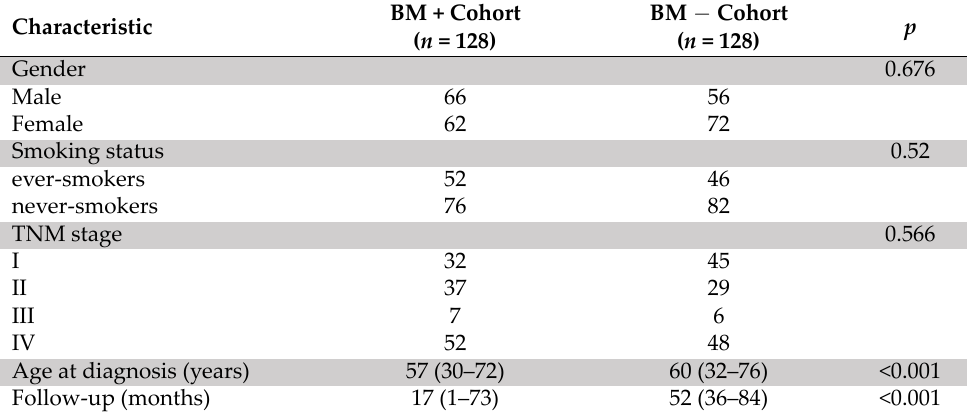
Table 1. Patients’ clinical